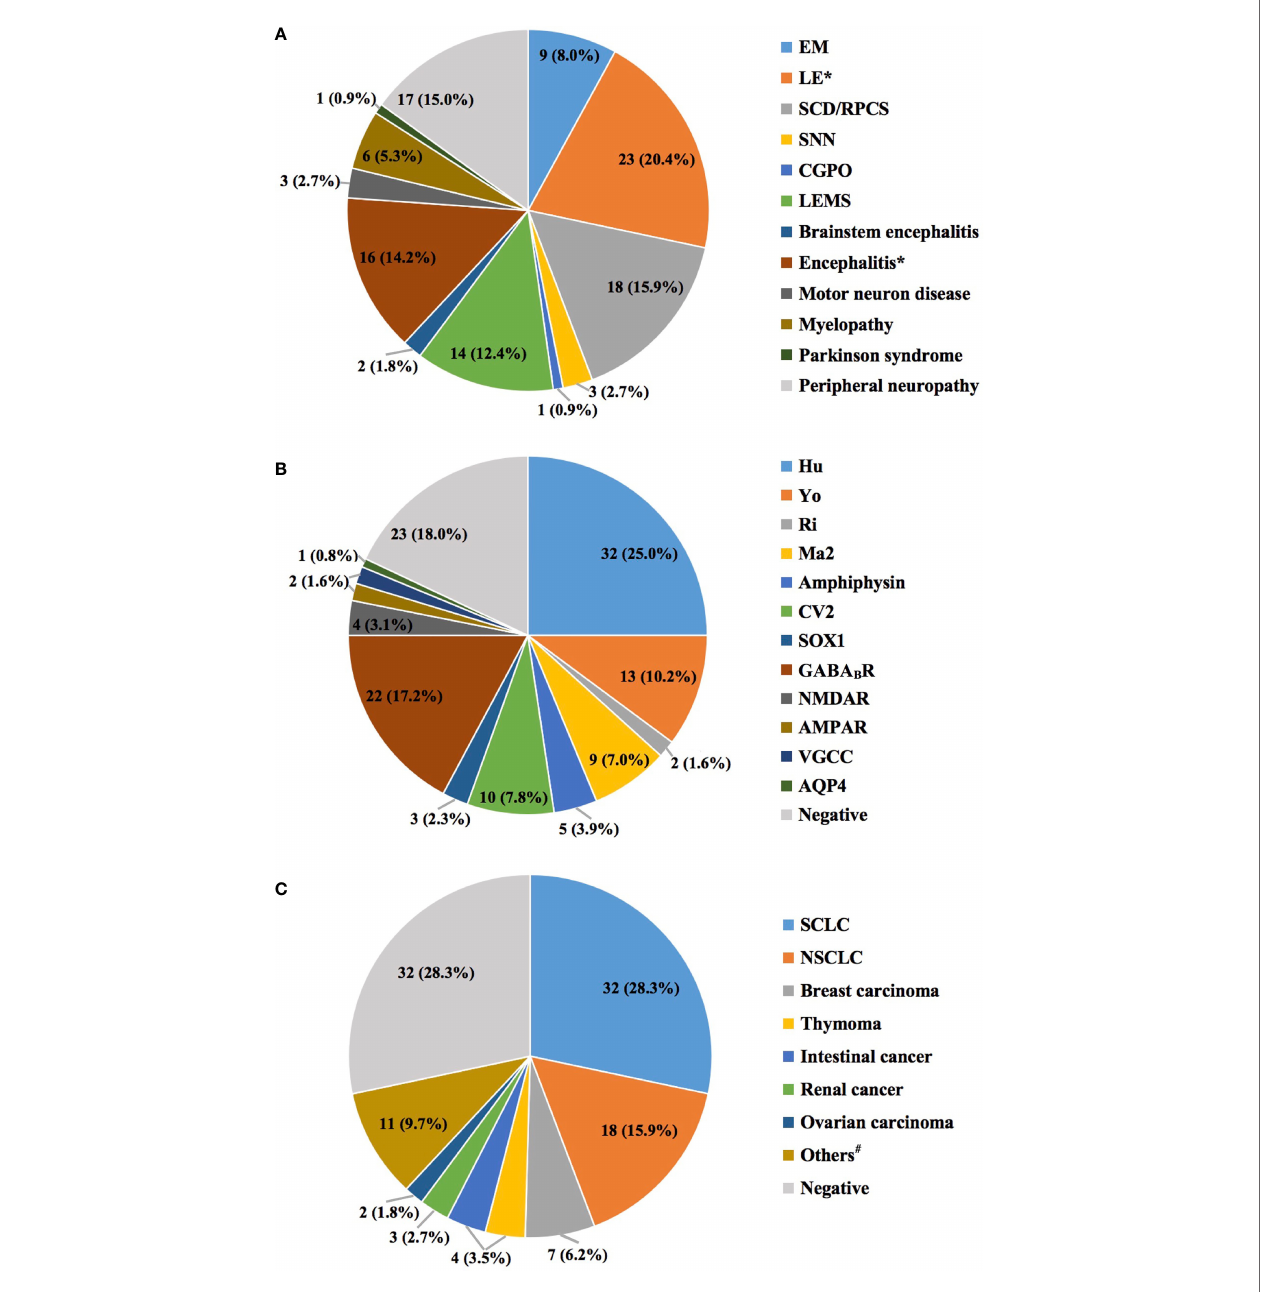
FIGURE 2 | The distributions of clinical phenotypes (A) , antibody types (B) , and cancers (C) . The total number of clinical phenotypes and cancers was 113, compared with 128 antibodies. The former 2 features were unique in each patient, while coexisting antibodies were found in 14 patients (13 with 2 antibodies, and 1 with 3 antibodies). *Only 23 of the 35 patients initially diagnosed with LE ful fi lled the 2016 Lancet criteria (46), and the rest were classi fi ed as encephalitis. # Eleven types of cancers for each patient, including testicular cancer, cervical carcinoma, spinal cord tumor, palatal squamous epithelial carcinoma, lymphoepithelial carcinoma, mucosa-associated lymphoid tissue lymphoma, multiple myeloma, non-Hodgkin lymphoma, bladder cancer, ganglioneuroma, and gastric carcinoma. AMPAR, a -amino-3-hydroxy-5-methyl-4-isoxazolepropionic acid receptor; AQP4, aquaporin 4; CGPO, chronic gastrointestinal pseudo- obstruction; EM, encephalomyelitis; GABA B R, gamma-aminobutyric acid-B receptor; LE, limbic encephalitis; LEMS, Lambert – Eaton myasthenic syndrome; NMDAR, N -methyl- D -aspartate receptor; NSCLC, non-small-cell lung cancer; RPCS, rapidly progressive cerebellar syndrome; SCLC, small-cell lung cancer; SNN, sensory neuronopathy; VGCC, voltage-gated calcium